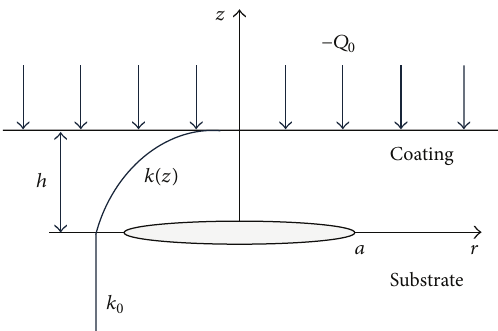
Figure 1: Geometry of the heat conduction